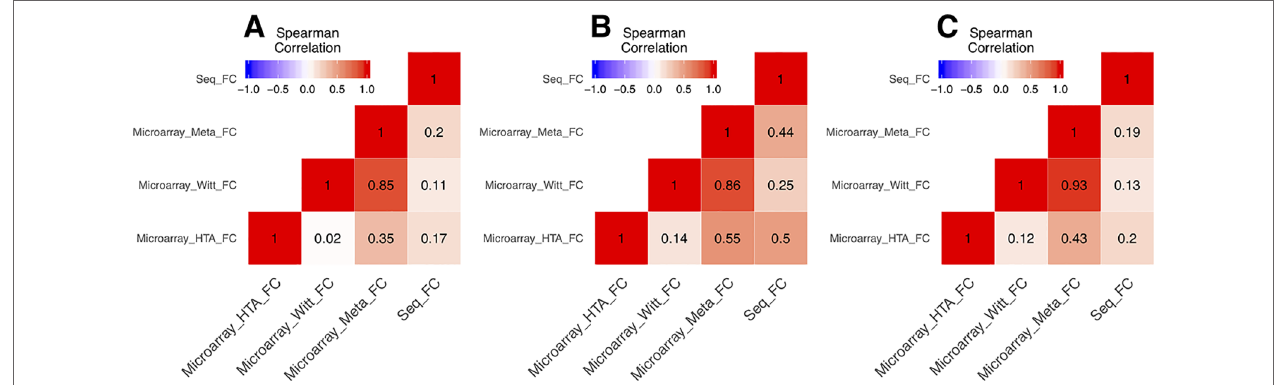
FIGURE 2 | The correlations of fold change between microarrays and RNA-Seq. All the correlations were conducted with Spearman’s correlation. (A) The correlations of fold change of all genes between microarrays and RNA-Seq. (B) The correlations of fold change of the coding genes among union DEGs between microarrays and RNA-Seq. (C) The correlations of fold change of the noncoding genes among union DEGs between microarrays and